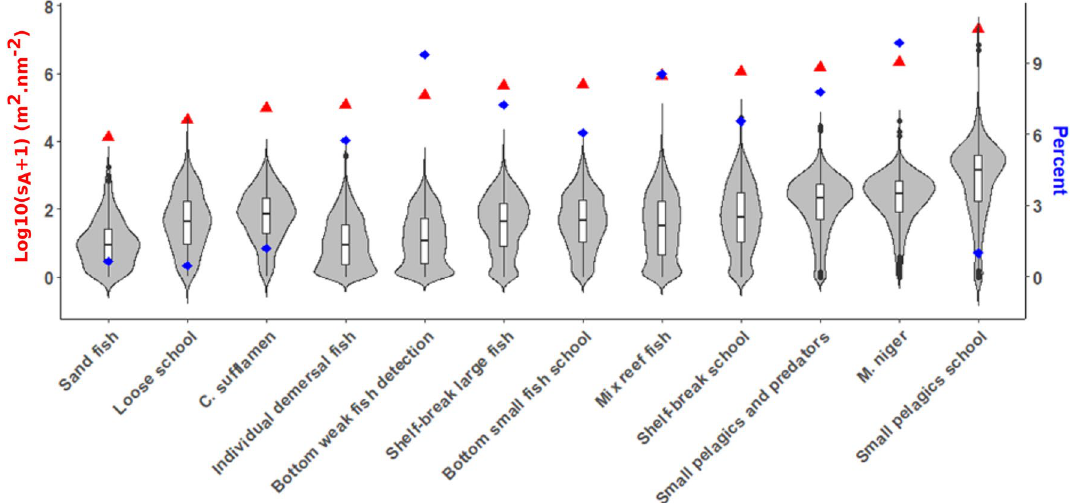
Figure 5. Violin plot containing boxplot representing the median (horizontal line), interquartile range, whiskers and outlying points of the acoustic biomass of individual assemblages (in log10(s A + 1)) by ESDU, their cumulative sum (red triangles) and the percentage of ESDU with presence of each assemblages (blue Fish-like acoustic biomass was significantly higher (mean log10(s A + 1) = 1.14 m 2 nm −2 ) in the mid-mesophotic zone (60–80 m) that encompasses the upper edge of the shelf-break than the lower euphotic (1.07 m 2 nm −2 ), followed by the upper mesophotic (0.92 m 2 nm −2 ), the upper euphotic (0.87 m 2 nm −2 ) and the lower mesophotic (0.85 m 2 nm −2 ). The no-fish acoustic biomass significantly increased with the bottom depth. It was higher in the lower mesophotic strata (mean log10(s A + 1) = 2.49 m 2 nm −2 ) where dense and strong layers of gelatinous were observed, than in the mid-mesophotic (2.25 m 2 nm −2 ), followed by the upper mesophotic (2.08 m 2 nm −2 ), the lower euphotic (1.84 m 2 nm −2 ), and the upper euphotic zone (1.37 m 2 nm −2 ). Finally, fish-like acoustic biomass was significantly higher inside (mean log10(s A + 1) = 1.18 m 2 nm −2 ) than outside (0.46 m 2 nm −2 ) the no-take zone. Although less marked, the same trend was observed for the no-fish Fish assemblages. Fish-like echoes were assigned to ten assemblages and two triggerfish species (Table 2). Video observations allowed a good identification of the species present for most of the groups. However, the composition of four groups (bottom weak fish detection, sand fish, loose school, shelf-break school) could not be fully validated by the videos. Small pelagic school presented the highest total acoustic biomass, followed by the black triggerfish (Fig. 5). The percentage of ESDU with presence of a given assemblage also mostly followed the trends in acoustic biomass with some notable exceptions. Small pelagic fish school that encompassed the highest acoustic biomass was only observed in 1% of ESDU (Fig. 5), indicating that they were concentrated within some large schools. On the opposite, M. niger was the most frequently observed assemblage (in 9.9% of ESDU) followed by bottom weak fish detection (9.4%) that ranked eighth in terms of total acoustic biomass. Fish assemblages presented specific spatial patterns of distribution (Fig. 6). Four assemblages (bottom small fish school, bottom weak fish detection, individual demersal and mix reef fish) presented the most comprehensive distributions over the shelf, all around FNA. The other assemblages associated to the shelf were loose school and sand fish, mostly distributed close to the coast and M. niger , mainly distributed on the windward side of FNA. Small pelagic schools were distributed both over the shelf and at the shelf-break. The other groups were mostly associated to the shelf-break, with shelf-break schools and shelf-break large fish distributed all over FNA while small pelagic and predators and C . sufflamen were mostly distributed on the windward side. The regression tree relating the fish-like acoustic biomass to the environmental parameters without consider- ing the sediment (Fig. 7a,c) reveals that the main driving factor is depth strata, discriminating between areas shal- lower (upper and lower euphotic, upper mesophotic) and deeper than 60 m depth (mid and lower mesophotic). Bottom depths shallower than 60 m correspond to the shelf where neritic assemblages dominate: bottom small fish school, mix reef fish, bottom weak fish detection, M. niger . Pelagic assemblages logically dominate in deeper areas: small pelagics and predators, shelf-break large fish and shelf-break school. Over the shelf, the next splits of the trees are depth strata, wind exposure, MPA protection and s A no-fish. Mix reef fish constituted 79% of the assemblages on the upper euphotic strata, it was also the dominant group (27%) in the lower euphotic and upper mesophotic strata on the leeward side outside the MPA. M. niger dominates (37%) on lower euphotic and upper mesophotic strata on the windward side with low no-fish acoustic biomass. On the pelagic side, shelf-break large fish dominated (29%) on the mid-mesophotic zone 60–80 m and small pelagic and predators (47%) on the lower mesophotic zone 80–100 m. When considering the reduced database containing sediment information (Fig. 7b,d), the first explicative variable was the sediment. On SaStCoRhAl sediment, M. niger dominates (73%) . For sediments other than SaStCoRhAl, the next splits of the trees are sediment, no-fish acoustic biomass, wind